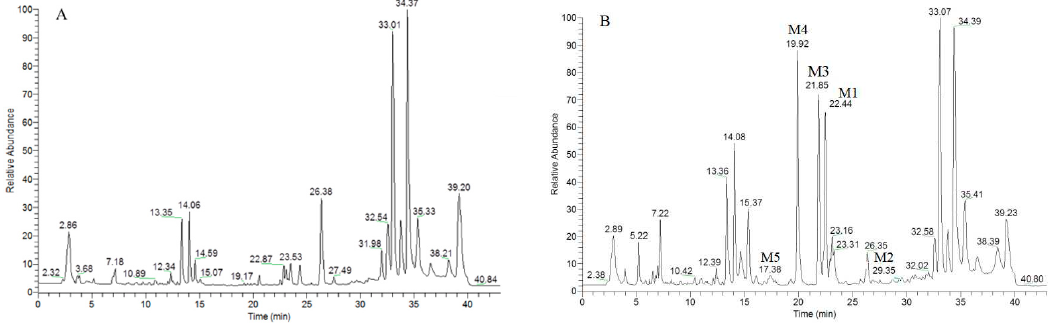
Figure 2. ( A ) The ion current chromatogram of control group; ( B ) the ion current chromatogram of administration group.